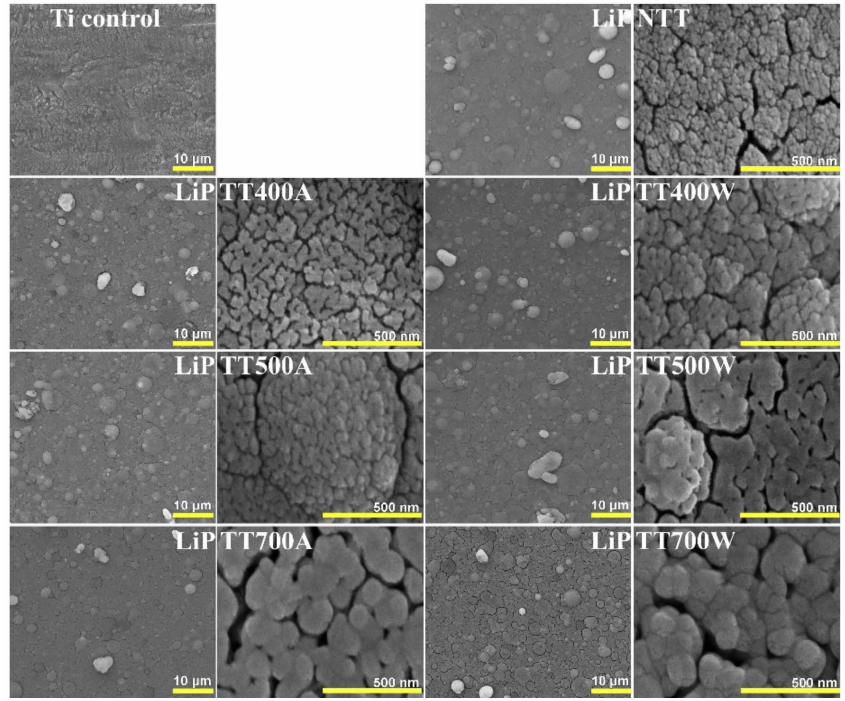
Figure 5. Top-view general and detailed SEM micrographs of control Ti, NTT LiP samples and of those subjected to post-deposition thermal treatments (at different temperatures), in air and water-vapor ambient, synthesized onto Ti